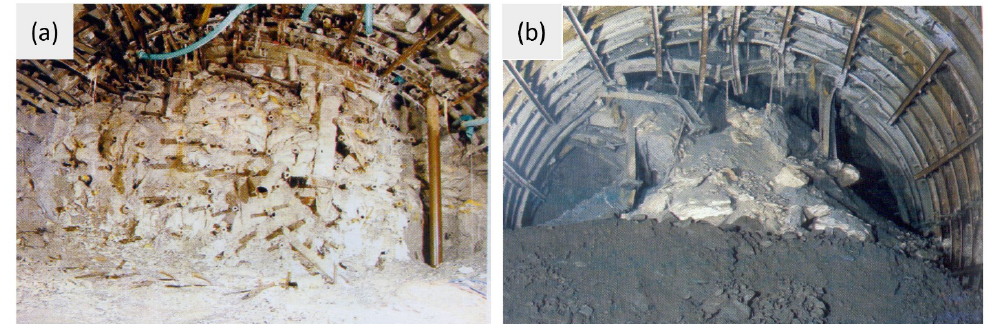
Figure 11. ( a ) Bamboo piling at tunnel face at the failed section; ( b ) failure of the ribs at the crown portion in THPS (Source: Dev et al.